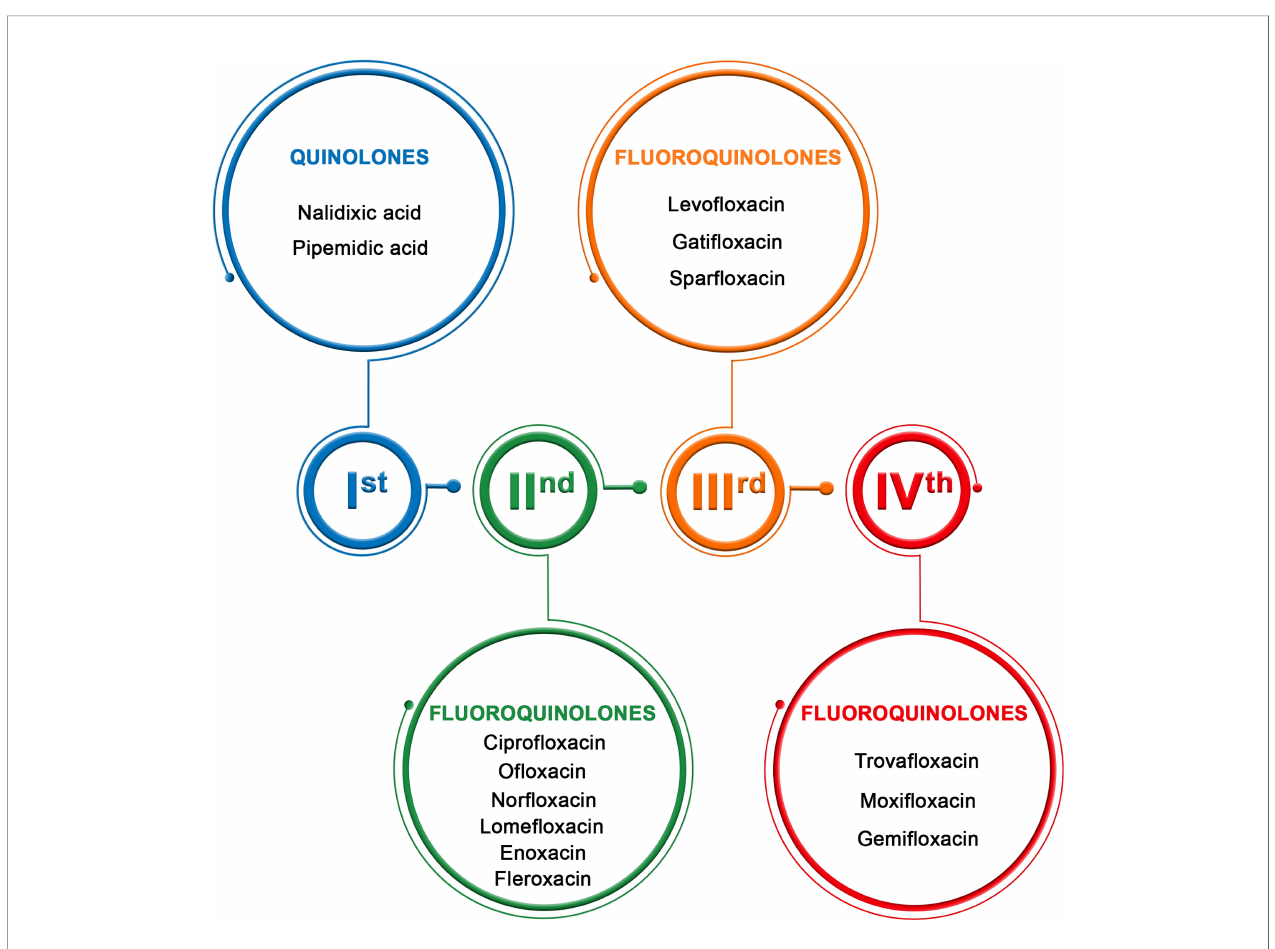
FIGURE 1 | Generation of quinolones